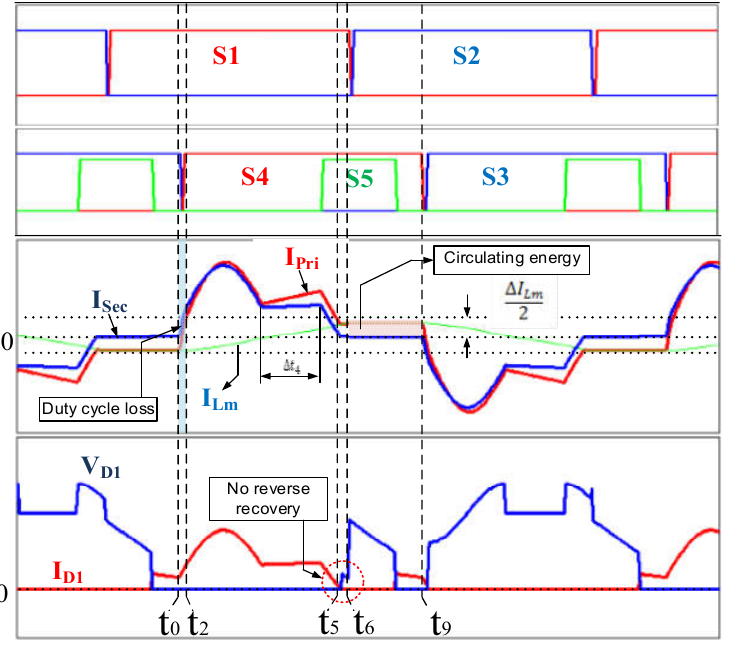
Figure 8. Small duty cycle loss, minimized circulating energy, and no reverse-recovery problem in the proposed converter.